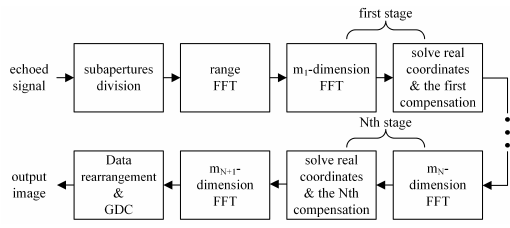
Figure 7. Flowchart of the proposed ML-OSA.